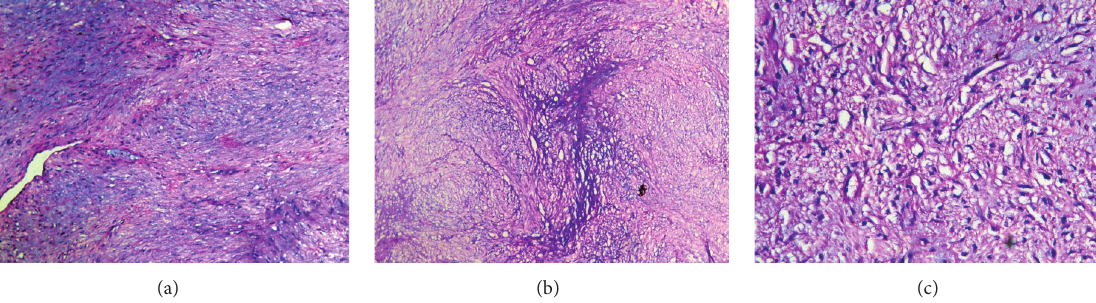
Figure 8: (a) Fibrous stroma with myxoid component (10x). (b) Chondroid tissue (10x). (c) Chondrocytes showing nuclear atypia, hyperchromasia, and pleomorphism